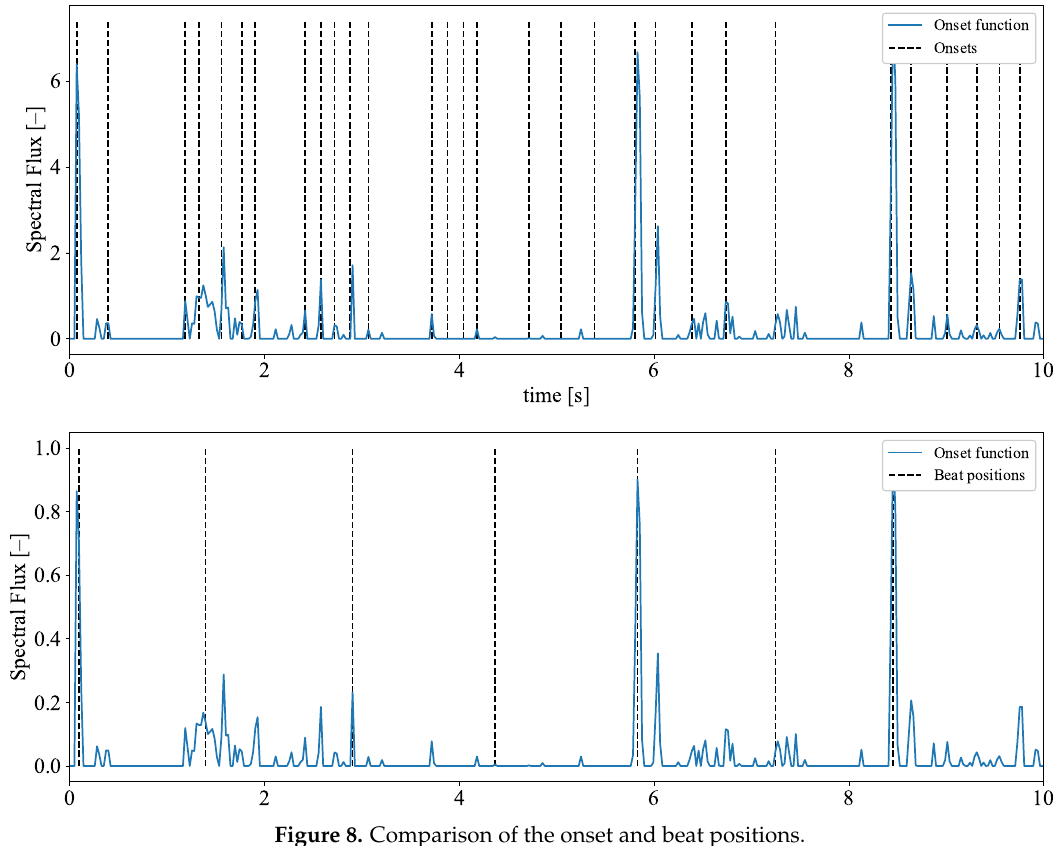
Figure 8. Comparison of the onset and beat positions.